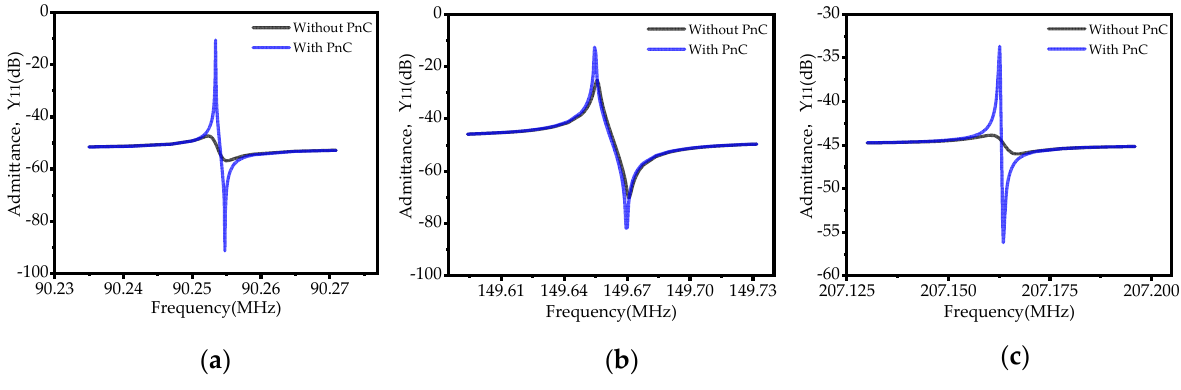
Figure 11. Admittance curves of the resonator under three successive overtones (( a ) third − order over-tone, ( b ) fifth − order overtone, and ( c ) seventh − order overtone).